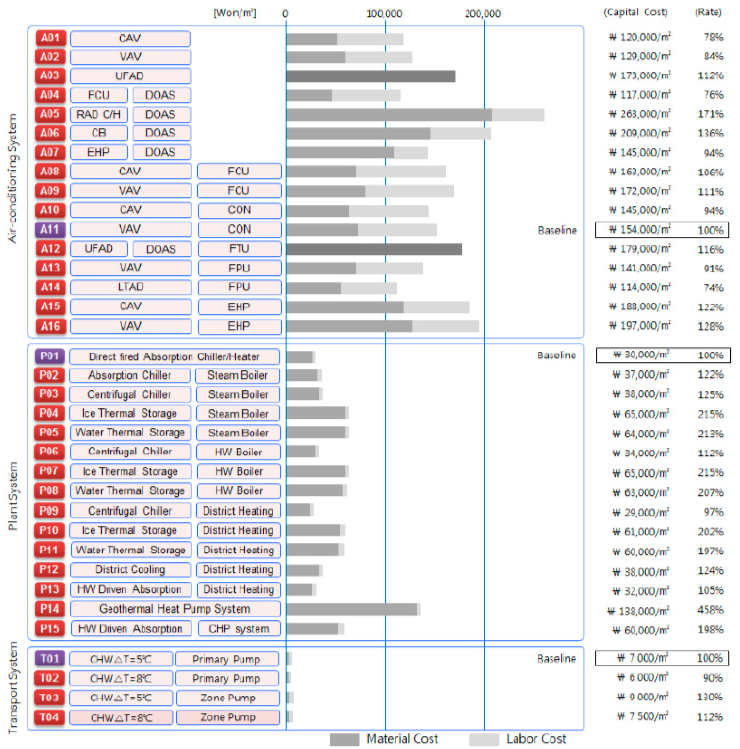
Figure 6. Analysis of construction cost of HVAC system boundary.